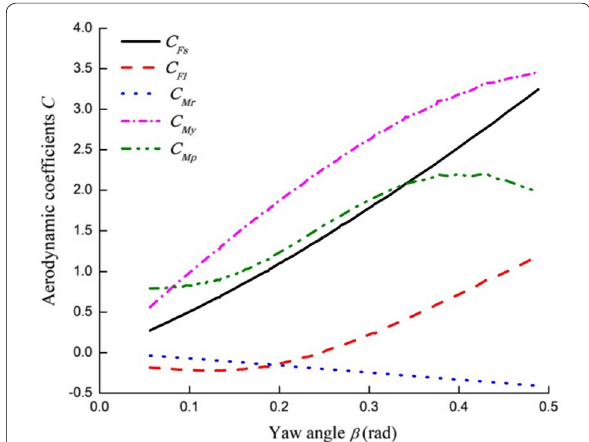
Figure 3 Aerodynamic coefficients